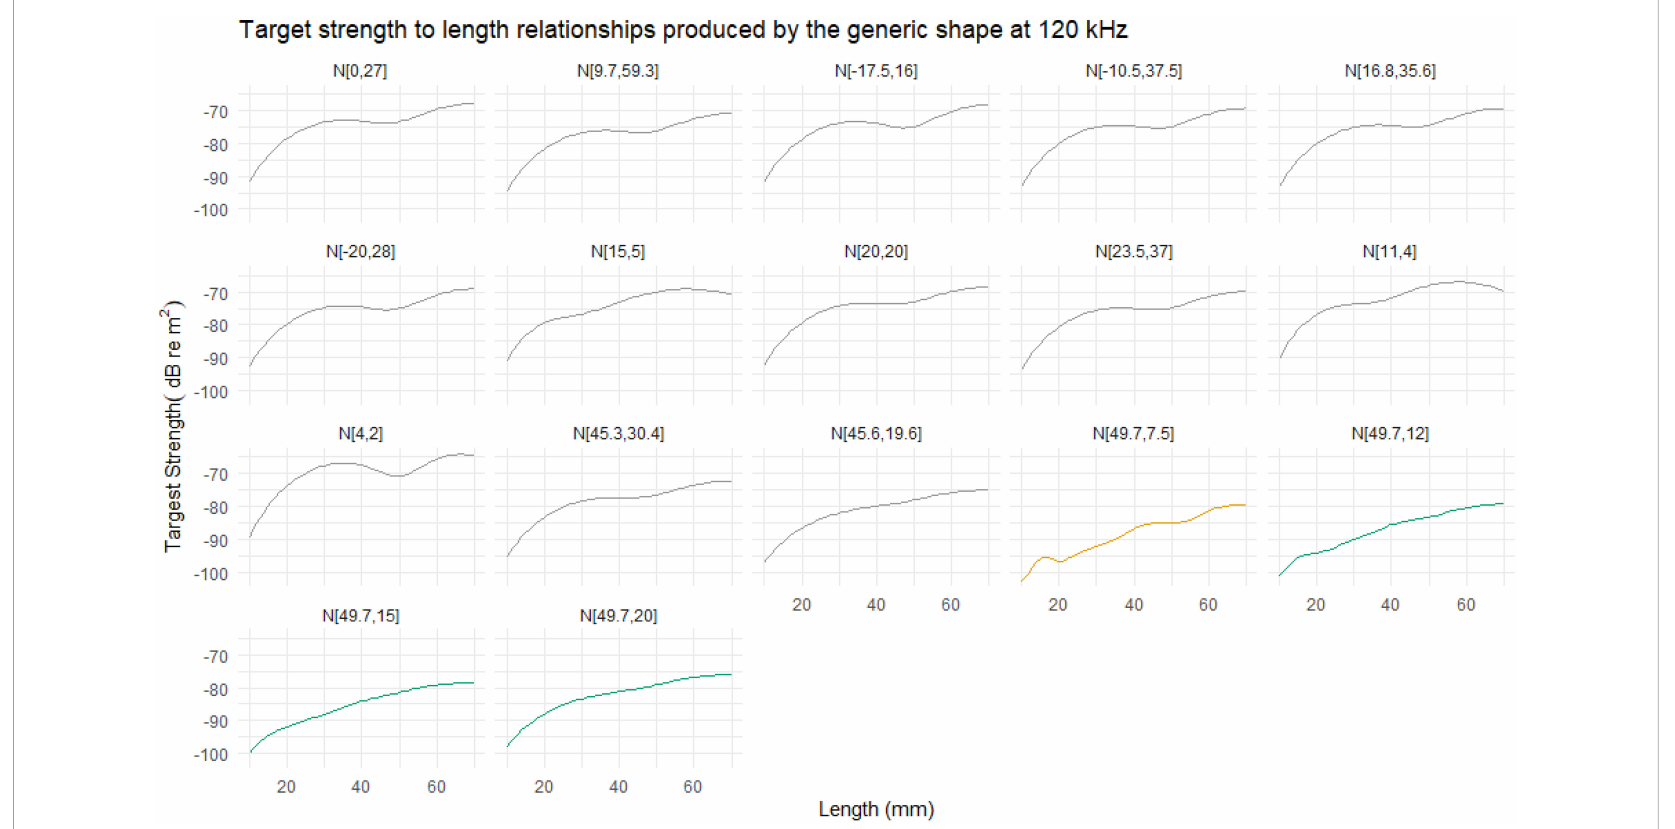
FIGURE 12 The relationship between target strength (TS) and length at 120 kHz for range of reported orientation distributions. Ten of the eleven reported orientation distributions show a typical relationship, where TS smoothly increases with length. The orientation distribution N [49.7°,7.5°] is highlighted in orange due to the atypical relationship. This distribution generally results in lower TS responses with a more variable relationship between TS and length compared to the other distributions. The results of three further orientation distribution are displayed, in green, to illustrate the effect of increasing the standard deviation of N [49.7°,7.5°]to 12°, 15°, and